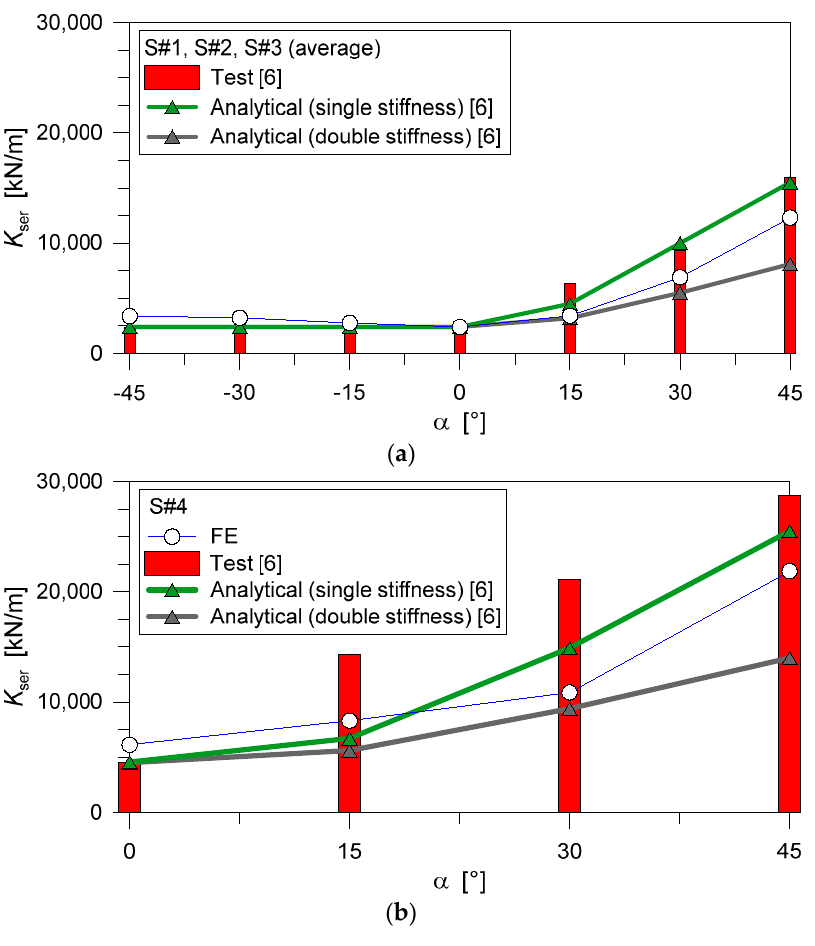
Figure 14. Comparison of numerical (ABAQUS/Explicit) and analytical [6] serviceability stiffness estimates for TTC joints with inclined STSs: ( a ) S#1-to-S#3 (average) or ( b ) S#4 joints. Appl. Sci. 2020 , 12 , x FOR PEER REVIEW